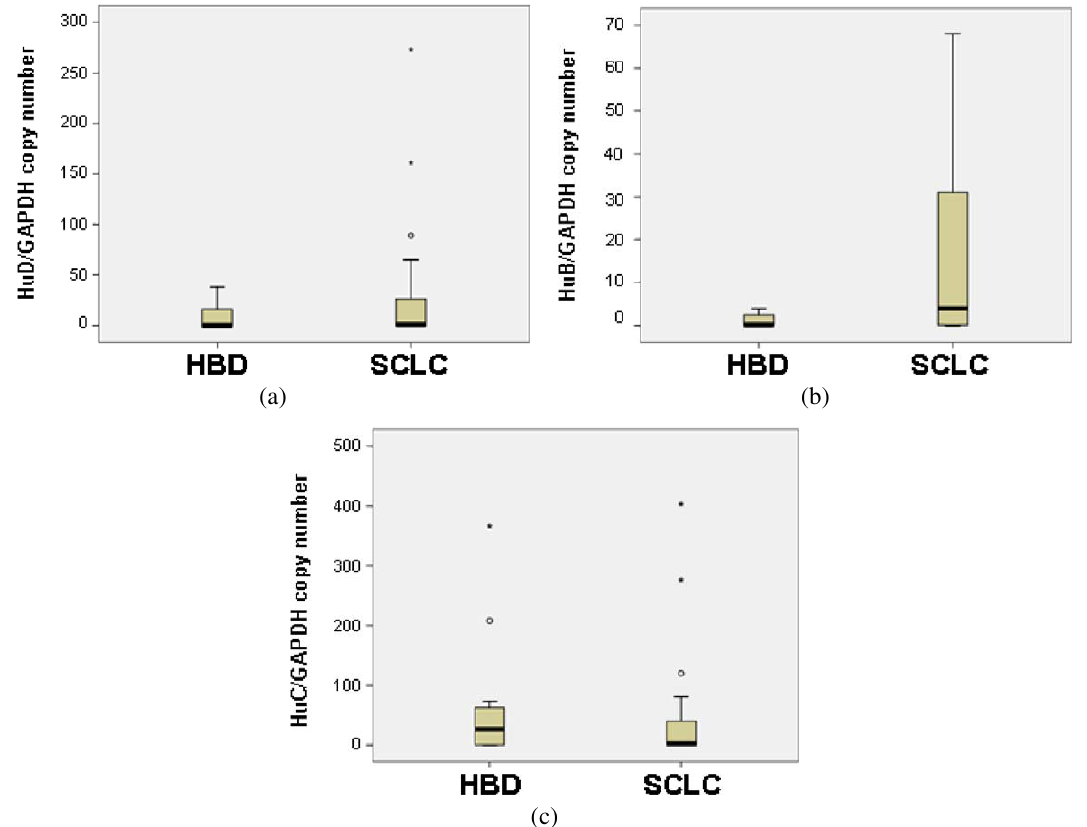
Fig. 1. Box plots transcripts in peripheral blood samples from healthy blood donors (HBD) and SCLC patients (SCLC) for HuD (a), HuB (b) and HuC (c). The boxes mark the interquartile range (interval between the 25th and 75th percentile). The lines inside the boxes denote median values. The whiskers represent the interval between the 10th and 90th percentiles. The empty circle indicate the outliners values between 1.5 and 3 length upper or down from the interquartile range. ‘*’ indicates the extreme cases with more than three boxes length upper or down from the interquartile